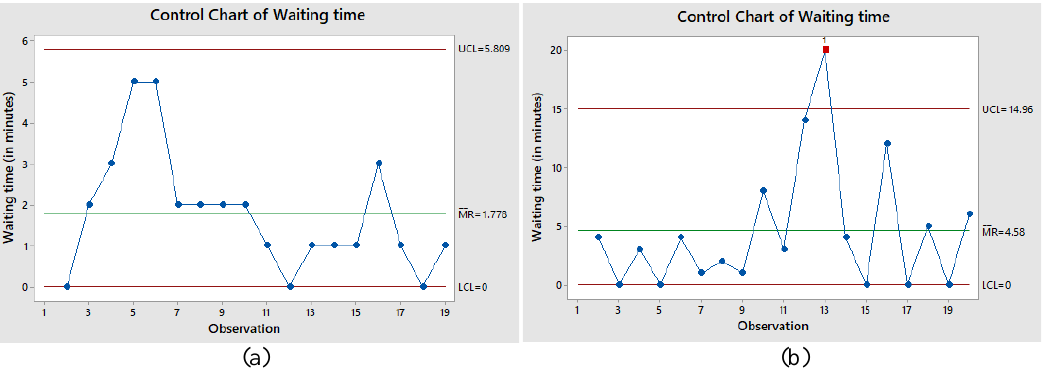
Figure 12. Control chart without special cause variation (a) and with special cause variation